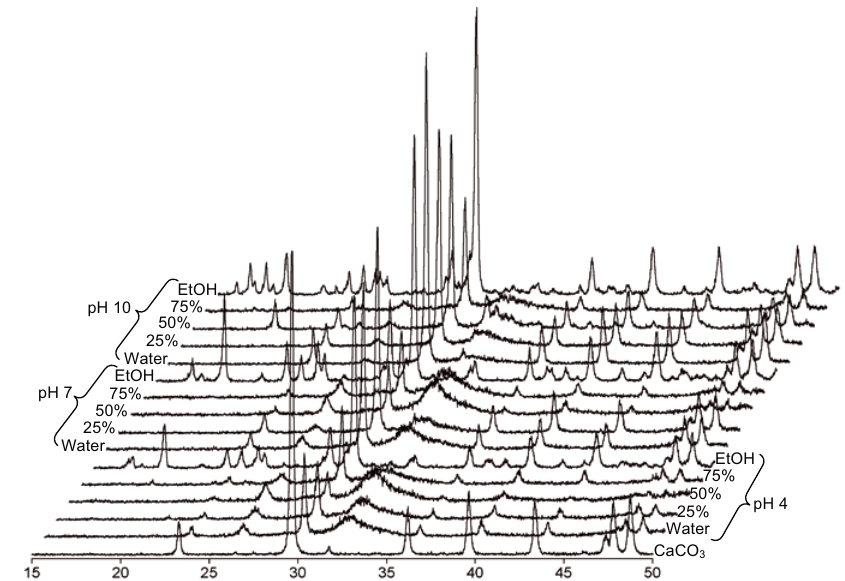
Figure 2. XRD patterns of the products obtained at room